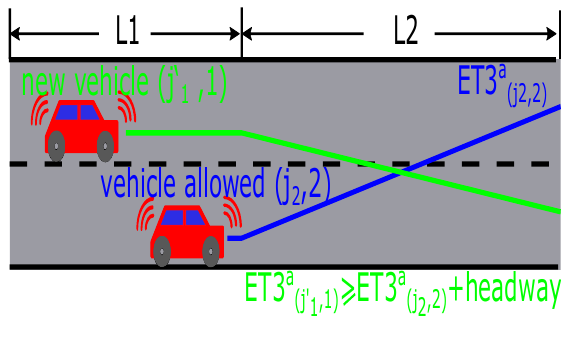
Figure 5. Lane change